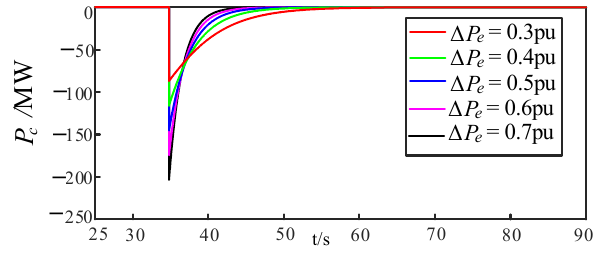
Figure 7. response of compensated power of VSC of different